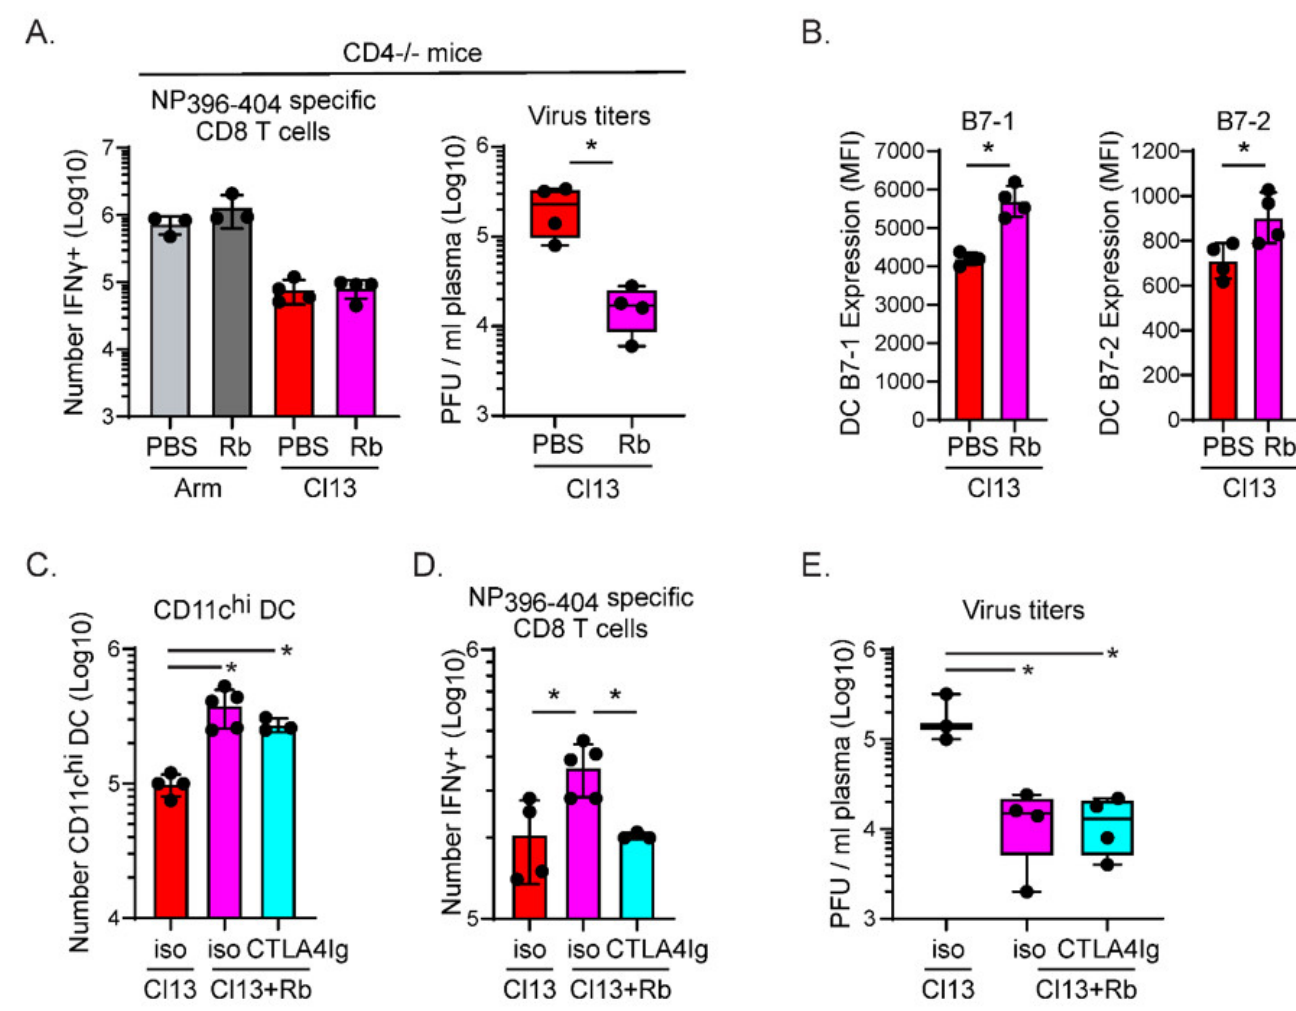
Figure 3. CD4 T cells and prolonged costimulation are required in combination with lower virus replication to prevent CD8 T cell deletion. ( A ). Splenocytes from PBS-treated or Rb-treated LCMV-Arm or LCMV-Cl13 infected CD4−/− mice were analyzed on day 9 after infection. The bar graph represents the number of IFNγ-producing NP 396 – 404 specific CD8 T cells and is the average ± SD of 4 mice per group. Box and whisker indicate day 9 virus titers in PBS-treated and Rb-treated CD4−/− mice infected with LCMV-Cl13. In the box and whisker plots, the midline represents the median and the error bars the minimum and maximum values (whiskers). Circles indicate individual mice. ( B ). Bars indicate the mean fluorescence intensity (MFI) of B7-1 and B7-2 expression on splenic CD11c hi dendritic cells in PBS treated or Rb-treated mice on day 9 after LCMV-Cl13 infection. Circles indicate the MFI in individual mice. ( C – E ). Splenocytes from PBS-treated or Rb-treated LCMV-Cl13 infected mice were analyzed on day 9 after infection. Mice were treated with PBS or Rb and then on days 4–8 after infection given CTLA4-Ig or an isotype antibody. Bars indicate ( C ) the number of CD11c hi dendritic cells, (D) the number of IFNγ-producing NP396-specific CD8 T cells, and ( E ) plasma virus titers. Data are representative of 2 or more experiments with 3–5 mice per group. * p < 0.05; student’s t-test (unpaired, two-tailed).